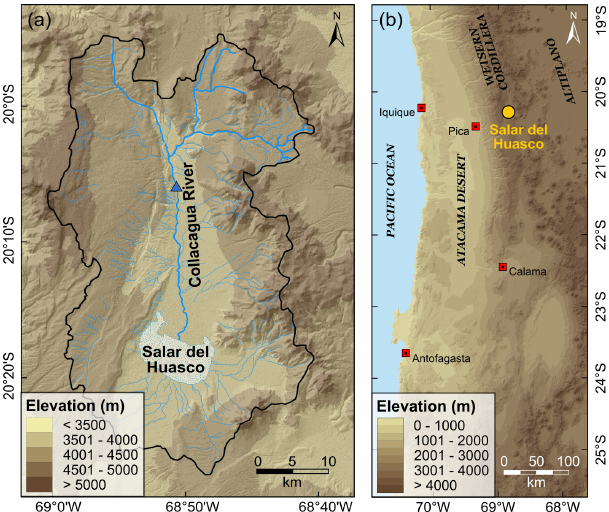
Figure 1. Study area. (a) Catchment of the Salar del Huasco (Salar del Huasco basin) with drainage. The blue triangle marks the sam- pling location of the Collacagua river. (b) Overview map (DEM derived from SRTM data, created using ArcGIS